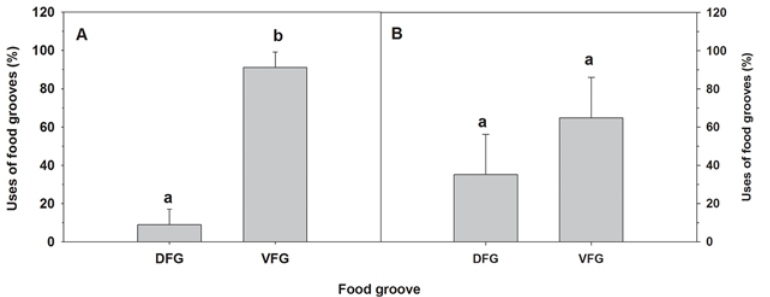
Fig 2. Ostrea chilensis. Food transport within the gill food grooves by adult oysters (A) non-brooding period and (B) brooding period. DFG: Dorsal food groove; VFG: Ventral food groove. Letters above the bars indicate significant differences (p < 0.05); mean + SD